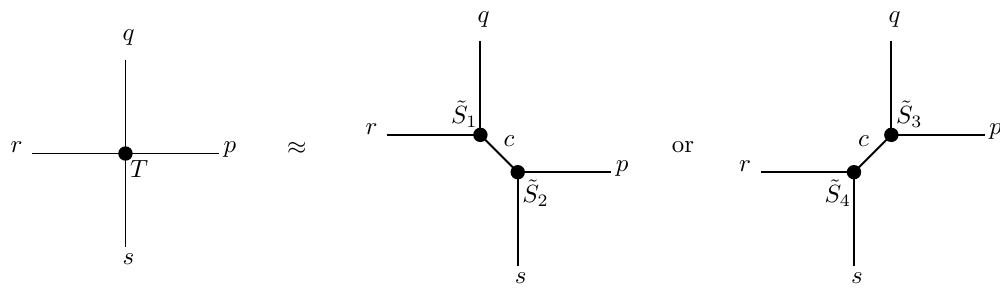
Figure 3 . The two types of SVD used for even sites and odd sites, respectively.